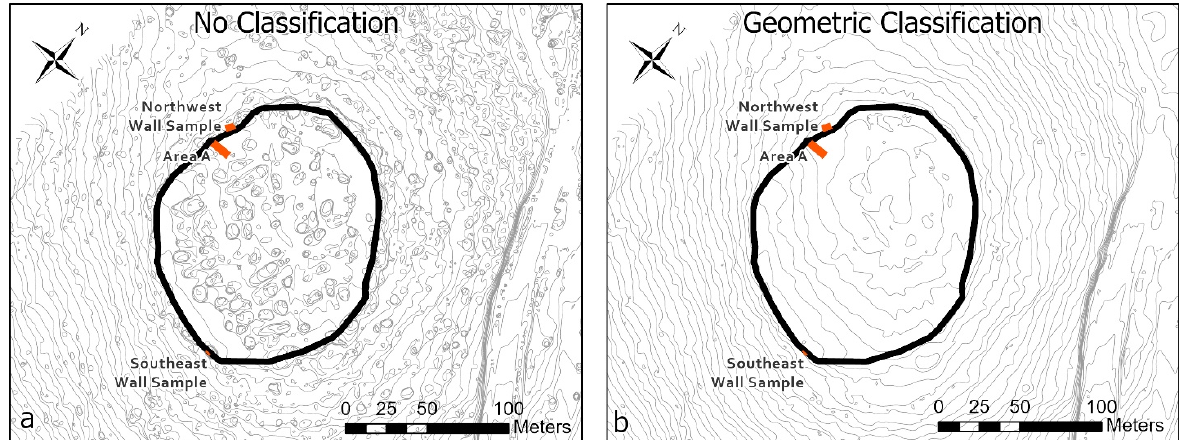
Figure 4. ( a ) Contour map produced from the unmodified DSM. Note the contours representing vegetation. ( b ) Contour map produced from the Classify Ground Points-derived, geometrically filtered DTM. In both cases, contour lines below 5 m have been removed and contours have been smoothed. These maps are also viewable in interactive format here: https://storymaps.arcgis.com/stories/39280437536b4c458817fa4aa5c0b541 (accessed on 19 November 2021).